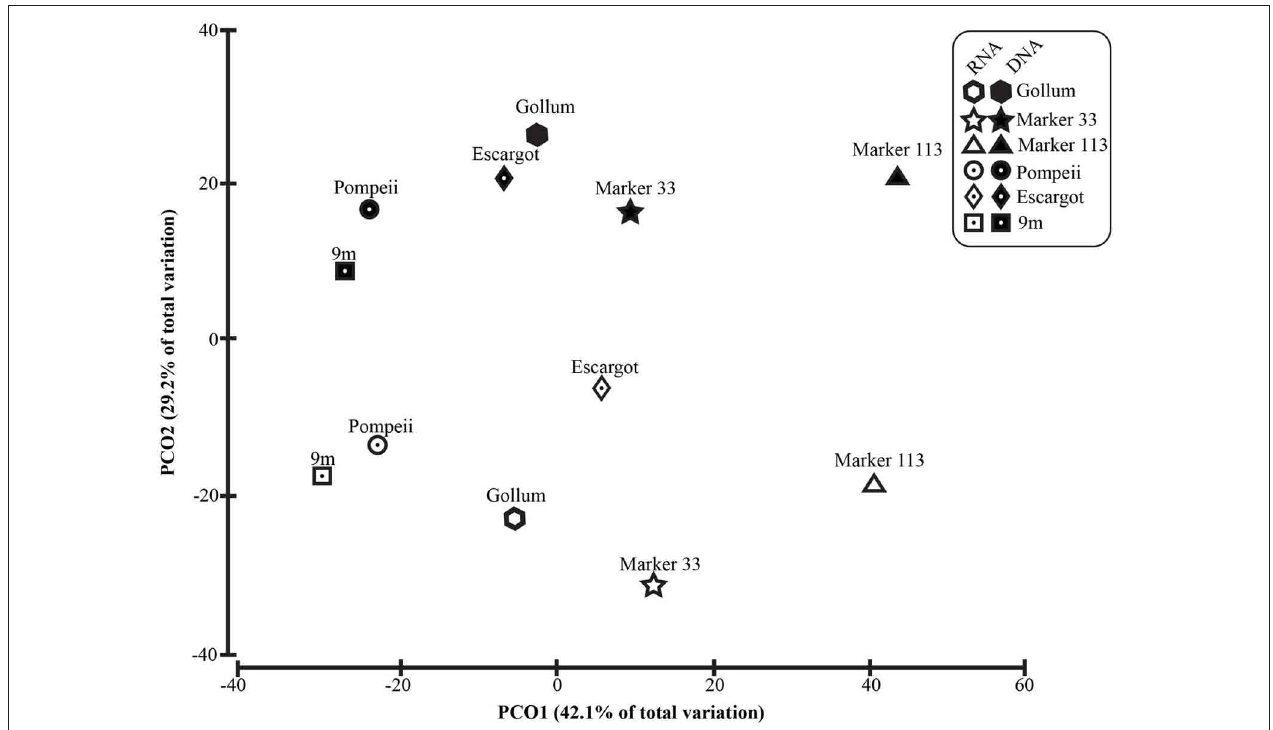
FIGURE 5 | Principal coordinates analysis of all 96% 16S rRNA gene